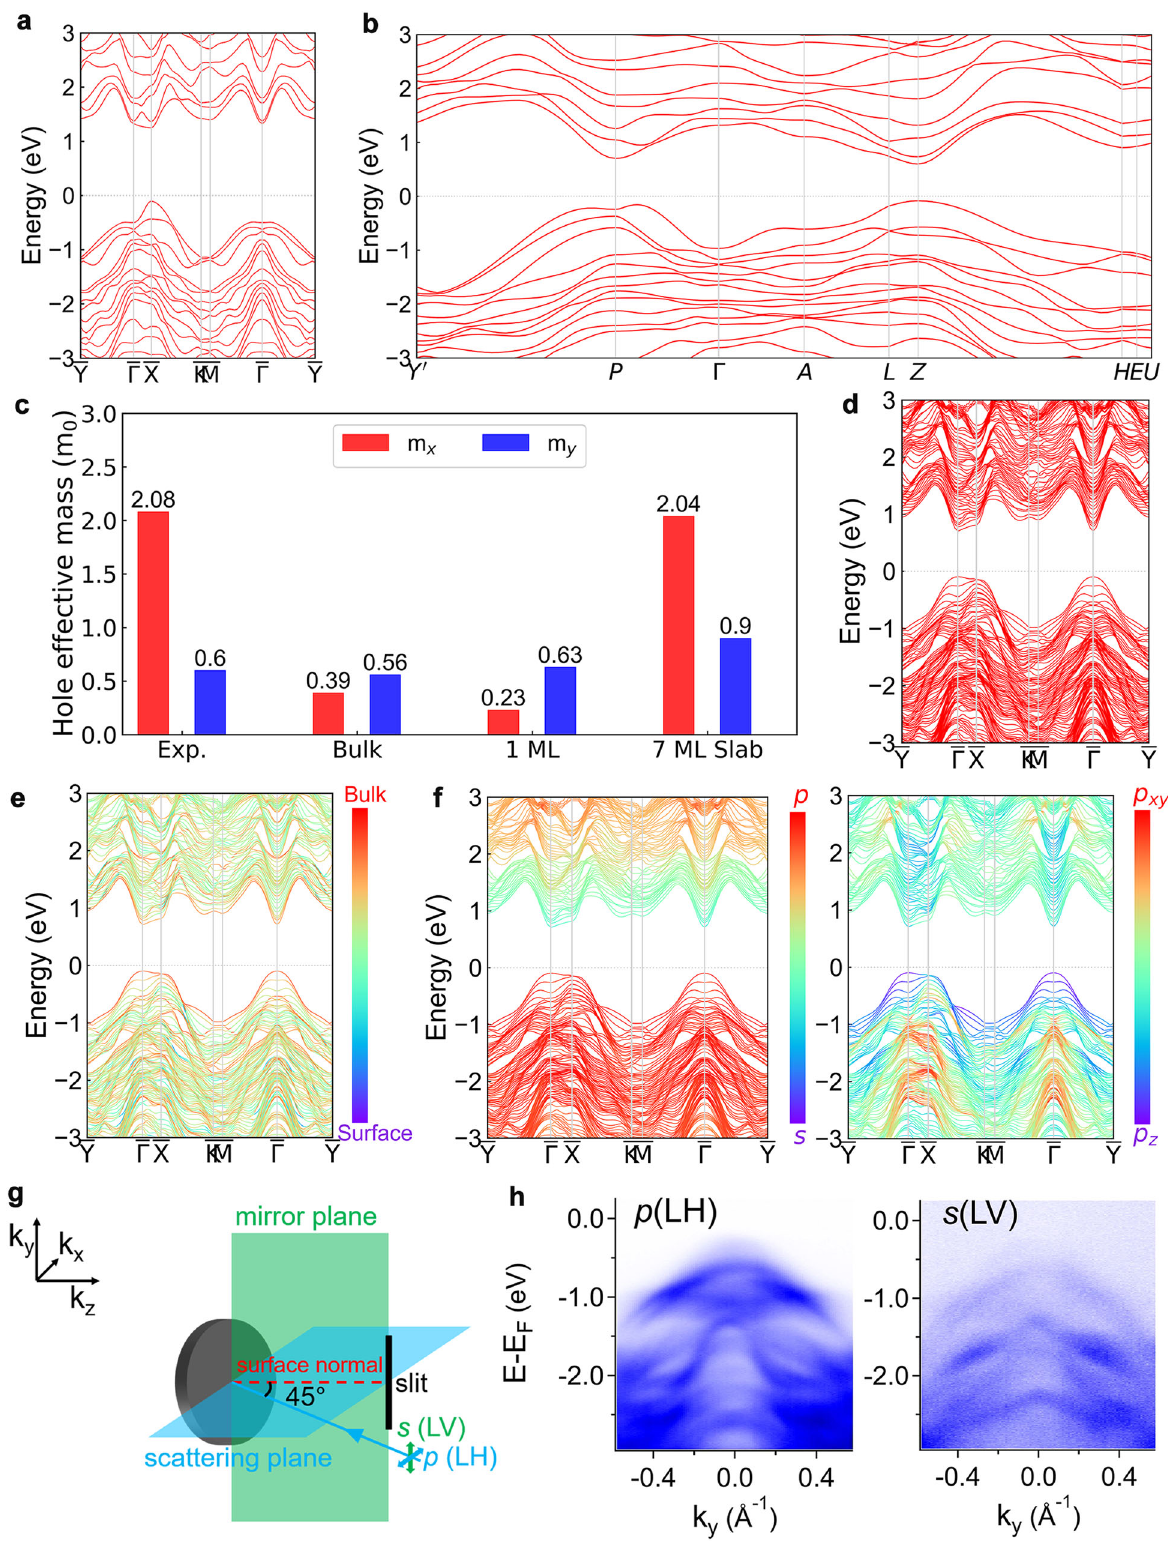
Fig. 2 Comparison between anisotropic band structures for experiment and theoretical models. a , b Band structures of monolayer (1 ML) and bulk GaTe calculated by the PBE + SOC method. c Hole effective masses for x and y direction for bulk, 1 ML and 7 ML slab con fi guration calculated by PBE + SOC method compared with experimental results in units of free electron mass m 0 . d Band structure of 7 ML GaTe slab con fi guration. e Spatial-resolved band structure of 7 ML GaTe slab con fi guration. f Orbital-projected band structure of 7 ML GaTe slab con fi guration. g Scheme of polarization-dependent angle- resolved photoemission spectroscopy (ARPES) measurement. h ARPES spectra of GaTe obtained by using p(LH)- and s(LV)- polarized light of 21.2